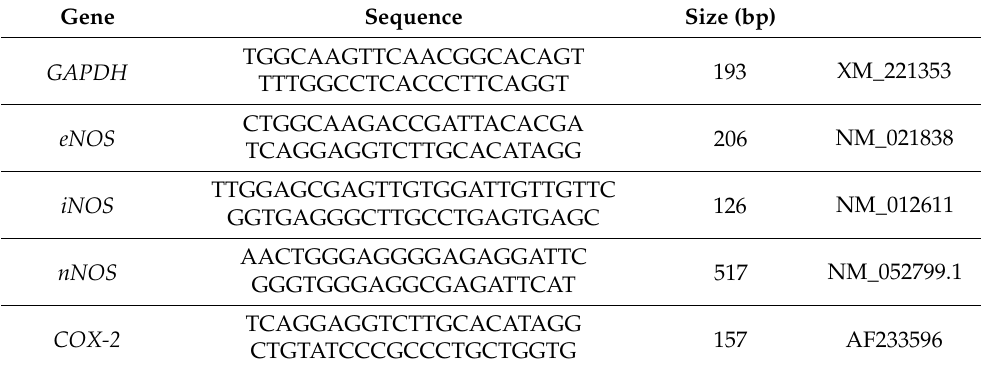
Table 1. Nucleotide